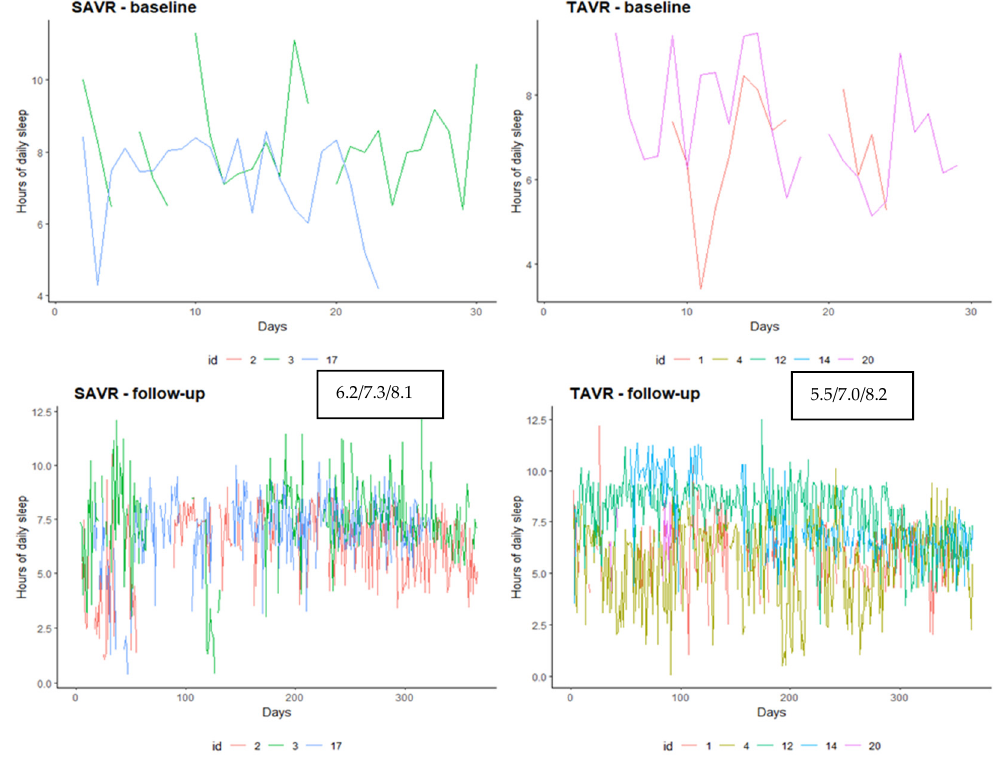
Figure 4. Number of hours slept trend recorded by the device according to procedure and baseline vs. follow-up period. Data in the box are the I, median and III quartile of hours of sleep.